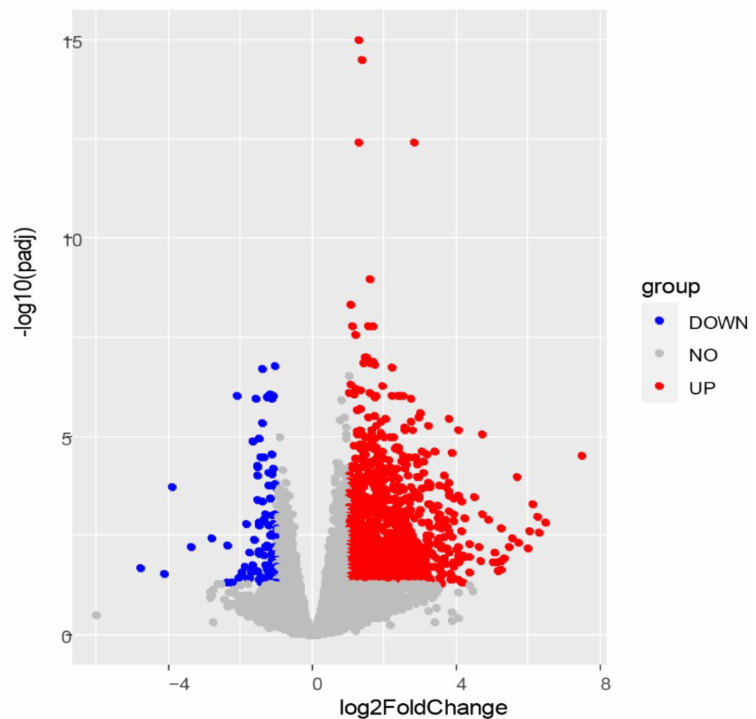
Figure 2. Volcano plot of differentially expressed genes. The red dots represent the 1133 upreg- ulated genes; the blue dots represent the 106 downregulated genes; the gray dots represent the unchanged